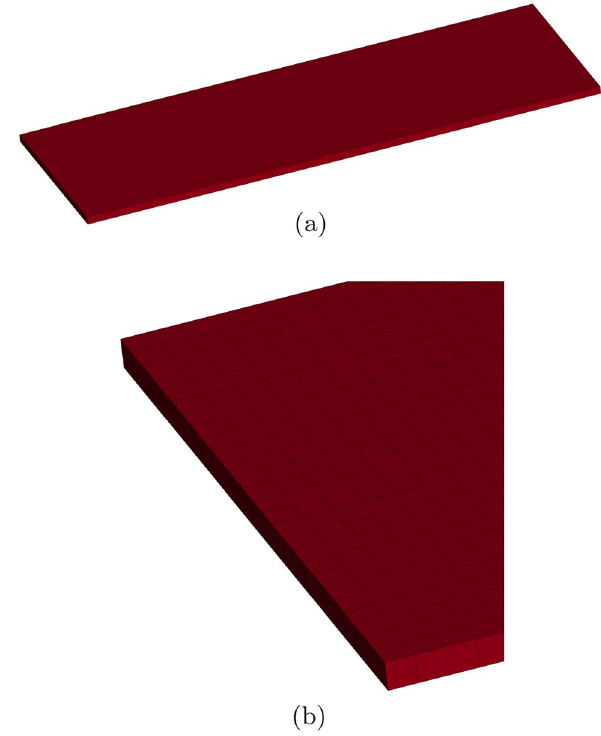
Fig. 7 In a and b the finite element mesh, using fully integrated solid elements, of the Hybrix™ core used for calibrating the consti- tutive models are